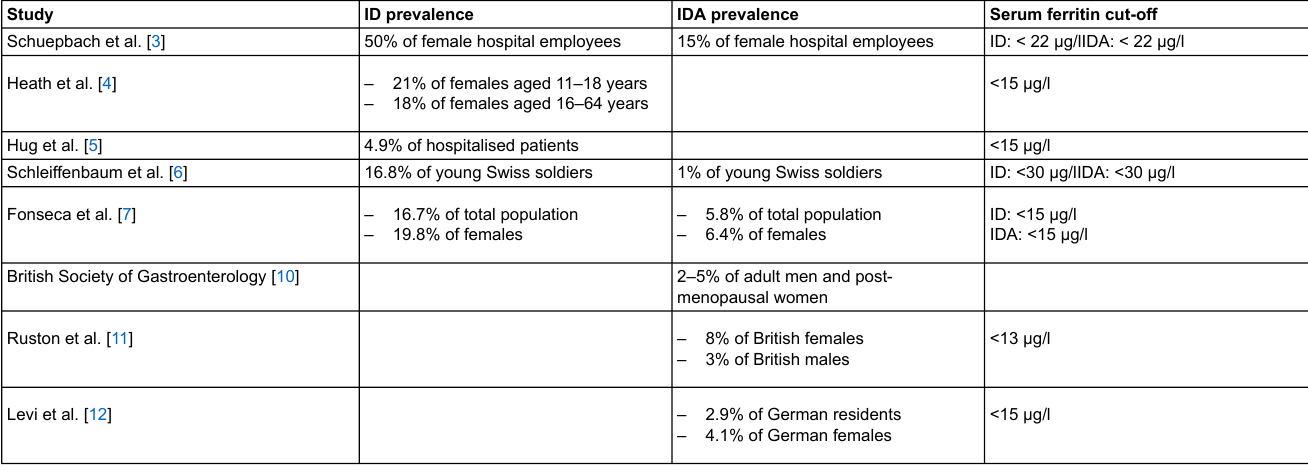
Table 1: Overview of iron deficiency/iron deficiency anaemia prevalence in different studies.